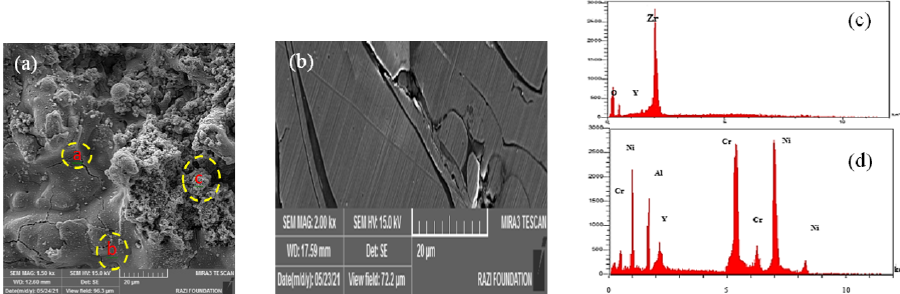
Figure 8: Nano YSZ surface (a) three model structure in nano YSZ, (b) Surface scanning electron micrographs of the surface of NiCrAlY coating, (c) EDS analysis of area a; and (d) EDS analysis of area b